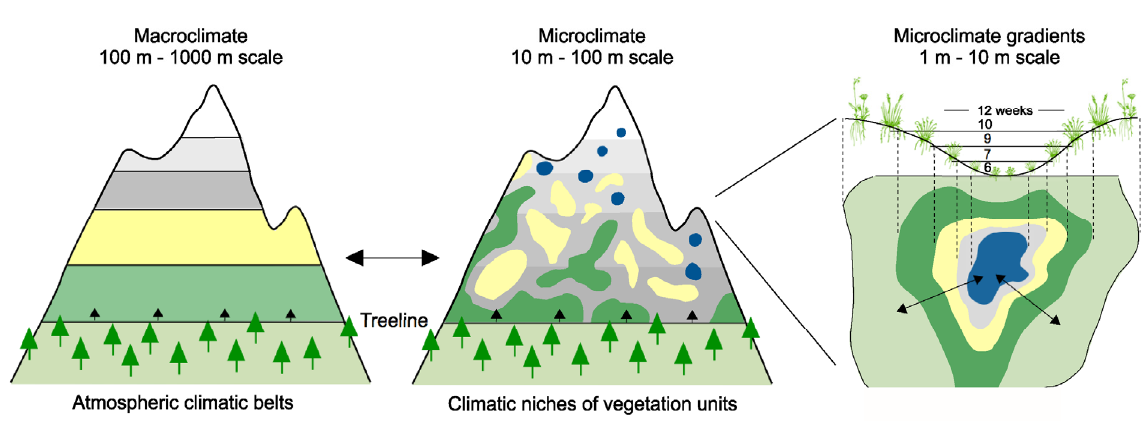
Figure 1. Above the treeline, the alpine vegetation follows the patterns of life conditions created by topography (microclimate) not captured by air temperatures obtained from weather stations (macroclimate). The mosaics of thermal habitats provides steep climatic gradients at very small scales (zoomed-in example to the right). Snow accumulation in snowbeds can cause the length of the growing season to vary by 6 weeks across a distance of 10 m, with even larger differences across exposure gradients (e.g., N-S aspect, wind